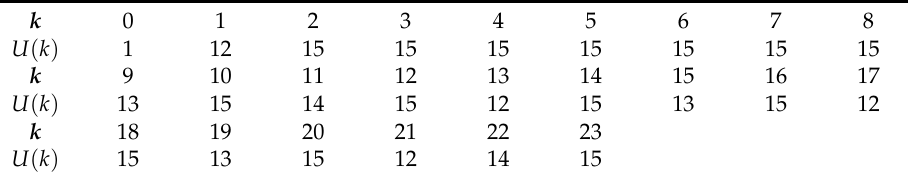
Table 3. Optimal production plan yielded by exact